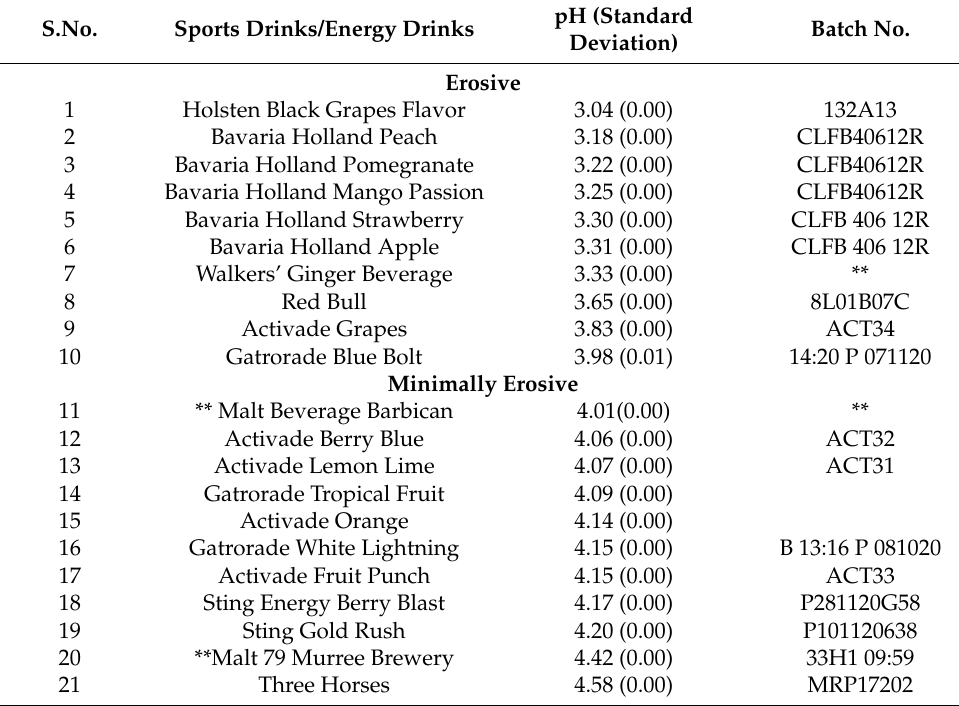
Table 1. pH (mean and standard deviation) of sports drinks/energy drinks.